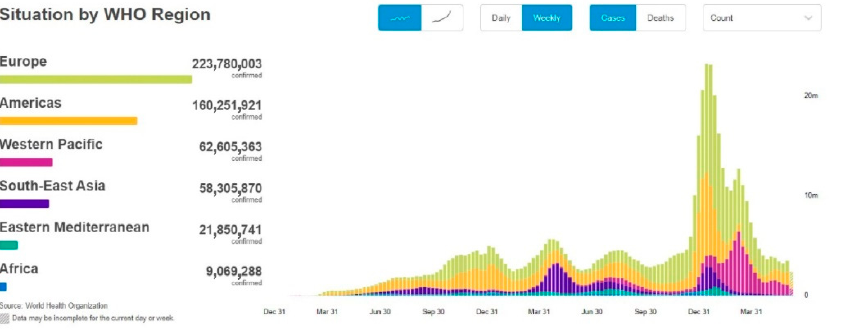
Figure 2. A screenshot of the COVID-19 situation by WHO Region. This dashboard is continually updated and can be accessed at https://covid19.who.int/ (accessed on 17 June 2022).